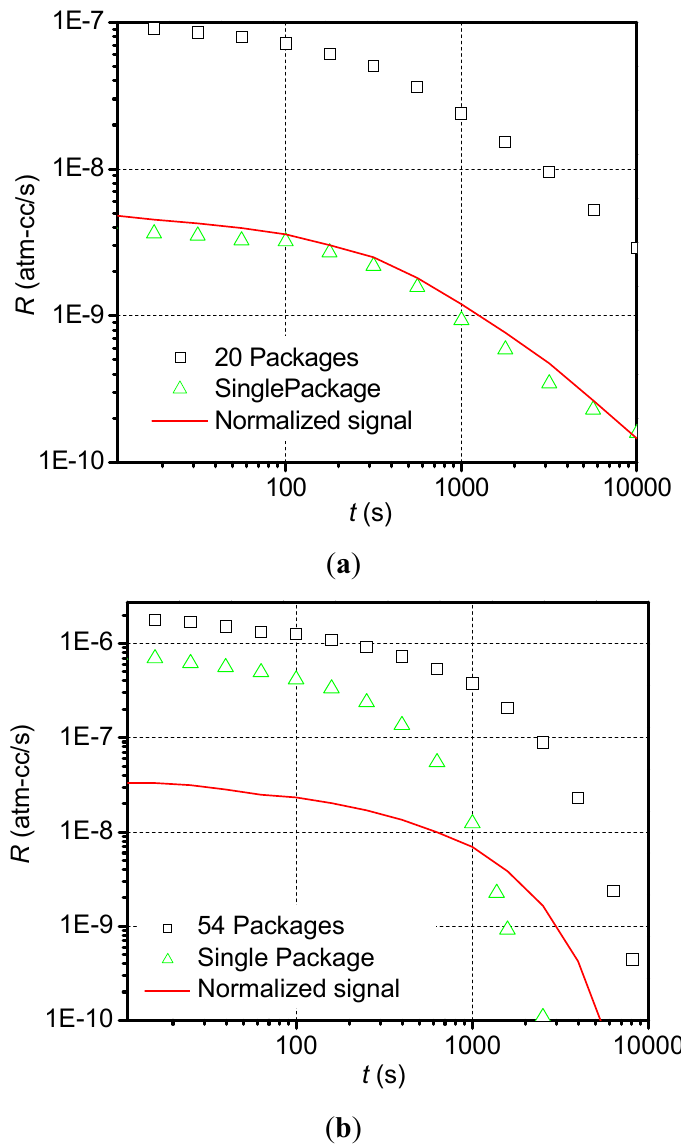
− 4 = 3.1 × 10 cm 3 ) cavity − 4 = 2.156 × 10 cm 3 ). Test parameters include cavity